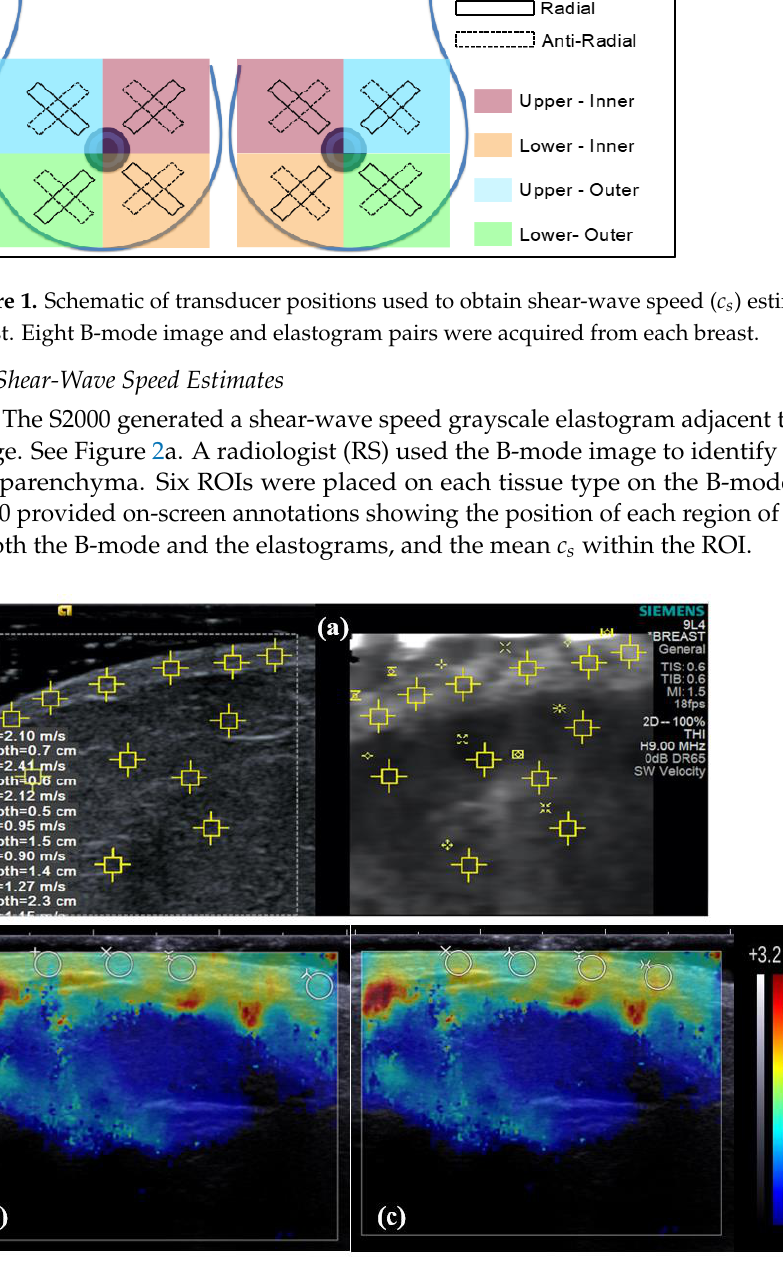
Figure 2. Showing: ( a ) An example B-mode image/elastogram pair acquired using the S2000 with ROIs marked on skin and parenchyma tissues (Volunteer 2); ( b ) an Aixplorer elastogram containing artefacts, overlaid with transparency on a B-mode image (Volunteer 2). In this example, c s values were estimated by placing ROIs (Q-boxes) in the regions free from artefacts; ( c ) the same image where the ROIs were positioned without knowledge of the position of the artefacts, achieved by reducing the opacity of the displayed elastogram to zero. Note that the Aixplorer only displays the last 4 ROIs selected. The Aixplorer provided an elastogram superimposed on the B-mode image where red and blue indicated greater and lesser c s , respectively, as shown in Figure 2b. The small- est available ROI, 2 mm in diameter, was placed at six different locations on the skin, adipose and parenchyma, respectively. The anatomical regions of interest and the c s meas- urement points selected by the radiologist and annotated on S2000 images were used to guide the placement of the ROIs on Aixplorer elastograms, which was performed by EH. Image artefacts of high c s at regularly spaced intervals were observed in Aixplorer elastograms. These are visible as a regular pattern of greater shear wave speed in Figure 2b and as vertical lines of greater shear wave speed illustrated using an elastogram of a homogenous region of the phantom in Figure 3a. To study the effect of this artefact, the Aixplorer analysis was performed twice, once by choosing measurement locations that avoided the artefacts using both the B-mode image and the elastogram to position the ROIs, as in Figure 2b, and once with measurement locations selected using only the B- mode image by increasing the c s scale and reducing the opacity of the on-screen display of the elastogram to zero (see Figure 2c). In some elastograms, it was not possible to avoid some overlap of ROIs with regions that appeared to contain artefacts. In some cases, min- imising the inclusion of artefacts reduced the number of measurement positions available. The number of c s estimates obtained using the Aixplorer when avoiding artefacts varied between two and six.